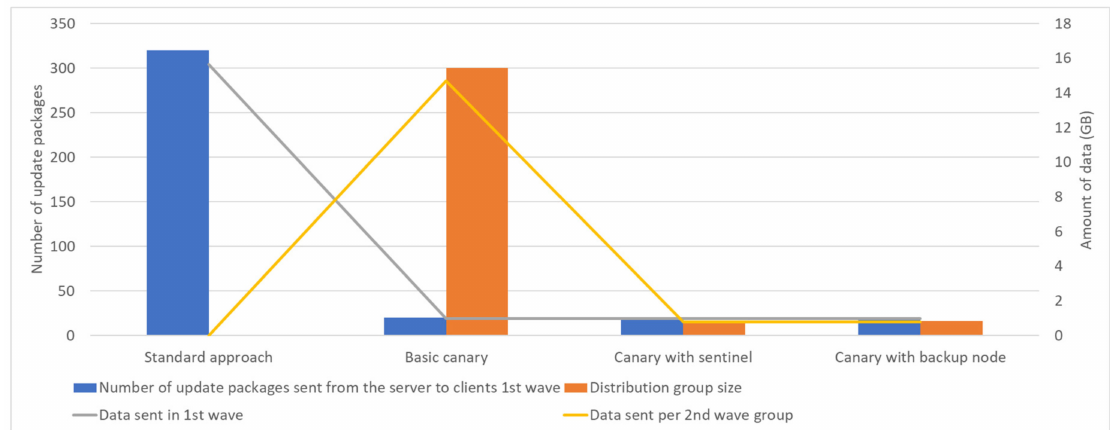
Figure 14. Comparison of the number of update packages and distribution group size per different client deployment approaches.